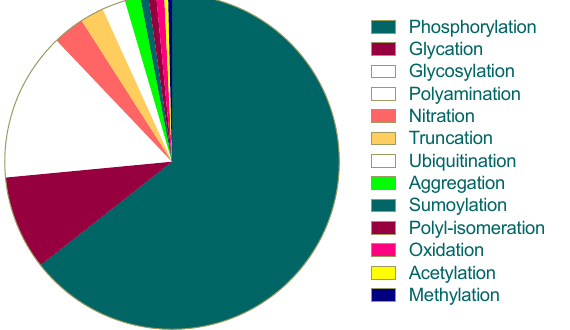
Figure 4. Proportion of PTMs on tau protein according to the number of targeted residues in the tau 2N4R isoform.